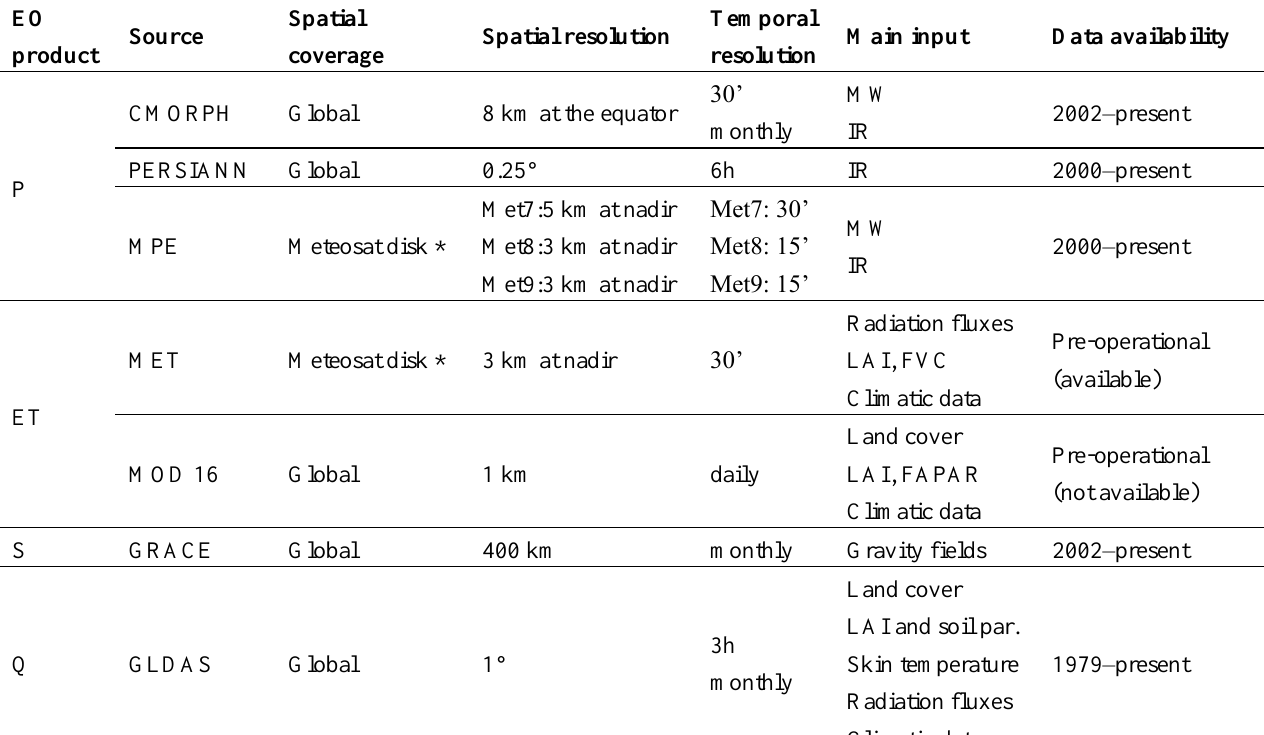
Table 1. Earth observation products (incomplete) involved in Equation (1): Source, spatial coverage, spatial and temporal resolution, main inputs and availability of data.